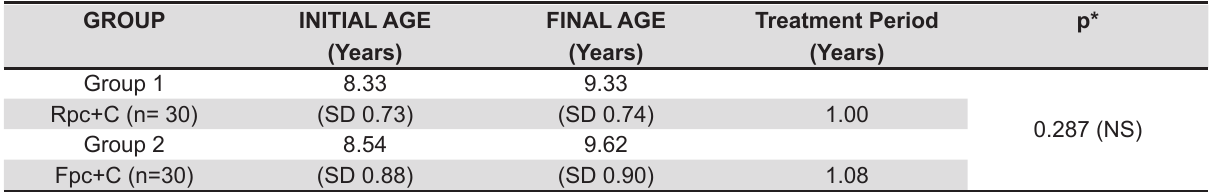
Table 1- Mean initial and final age and period of treatment